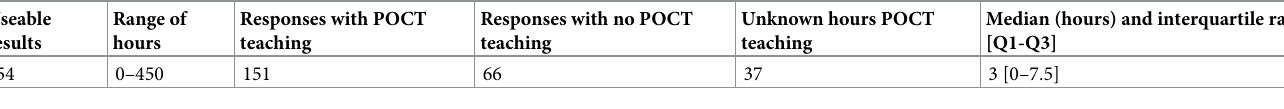
Table 5. Summary of hours dedicated to teaching point of care testing in the national health service.